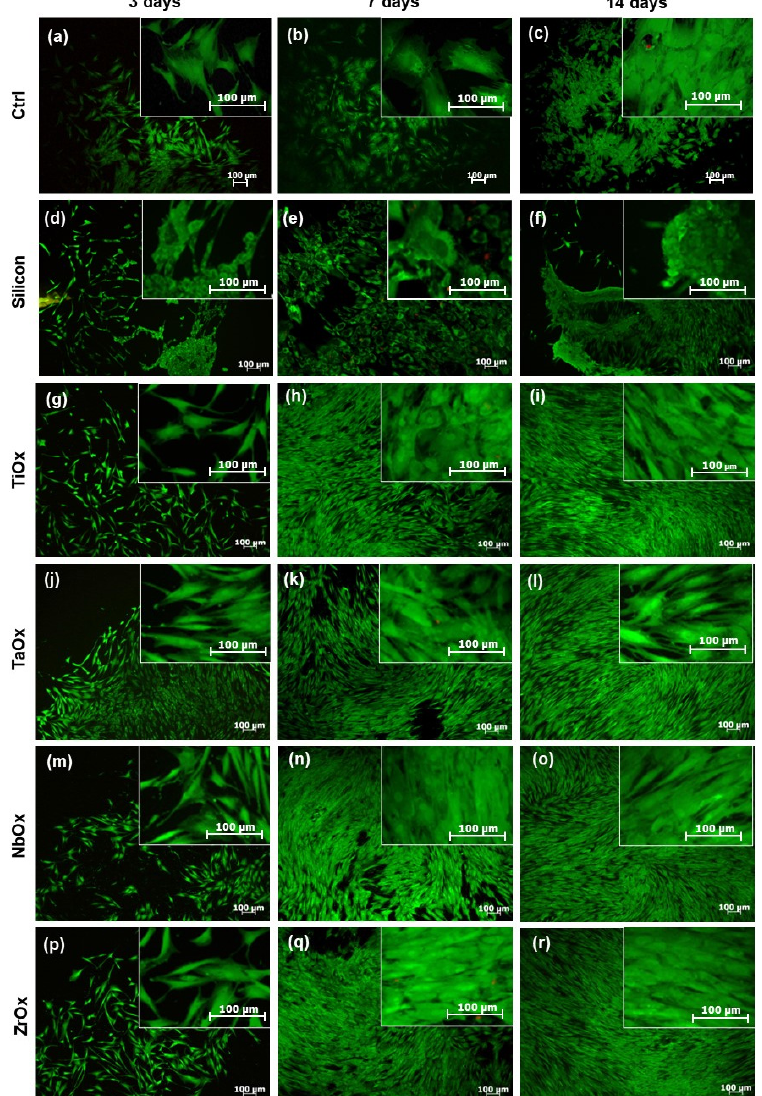
Figure 6. Qualitative evaluation of BM-MSC viability at 3, 7, and 14 days of culture on uncoated Si ( d – f ) and TiOx ( g – i ), TaOx ( j – l ), NbOx ( m – o ), and ZrOx ( p – r ) coated samples. Ctrl ( a – c ) corresponds to BM-MSC culture on the surface of standard tissue culture plates. Micrographs were acquired at